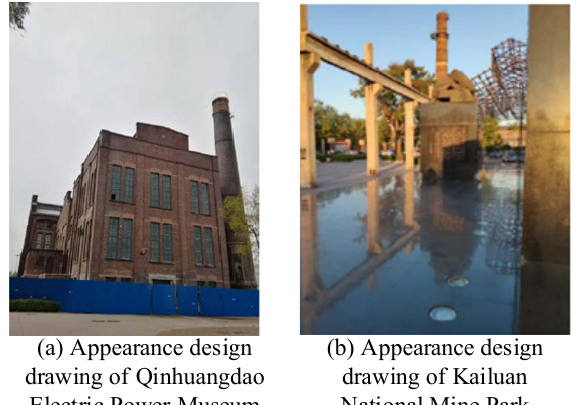
Figure 8. Design of Qinhuangdao Electric Power Museum and Kailuan National Park.